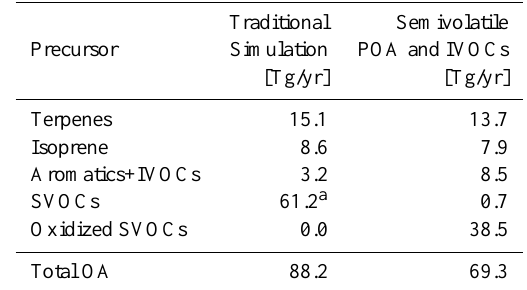
Table 3. Global net production of SOA (GEOS-Chem 2 ◦ latitude by 2.5 ◦ longitude horizontal resolution with GEOS-4